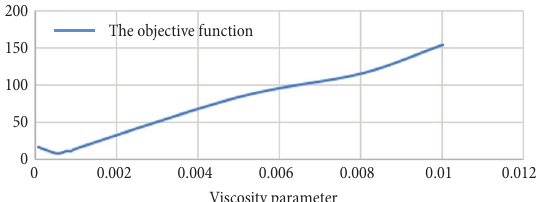
Fig. 21. The value of the objective function versus viscosity parameter in three-point notch beam